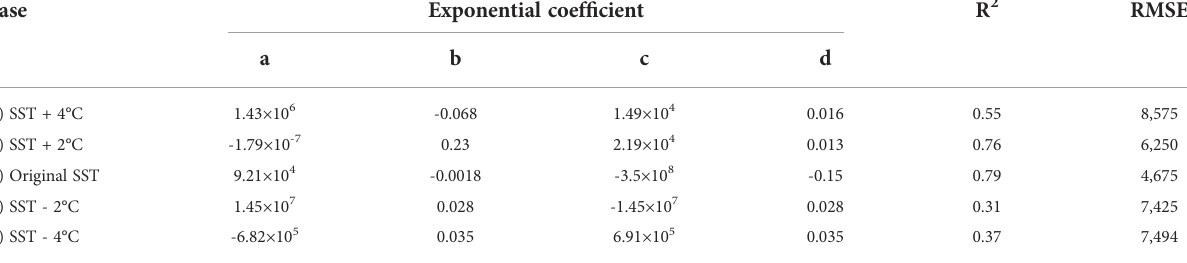
TABLE 4 Coef fi cient of the empirical polynomial regression for each case.